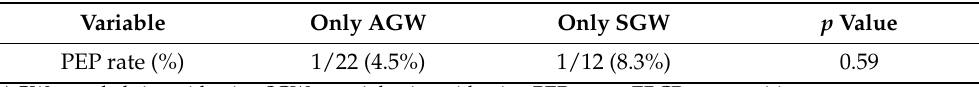
Table 4. Incidence rate of PEP at 14 min.